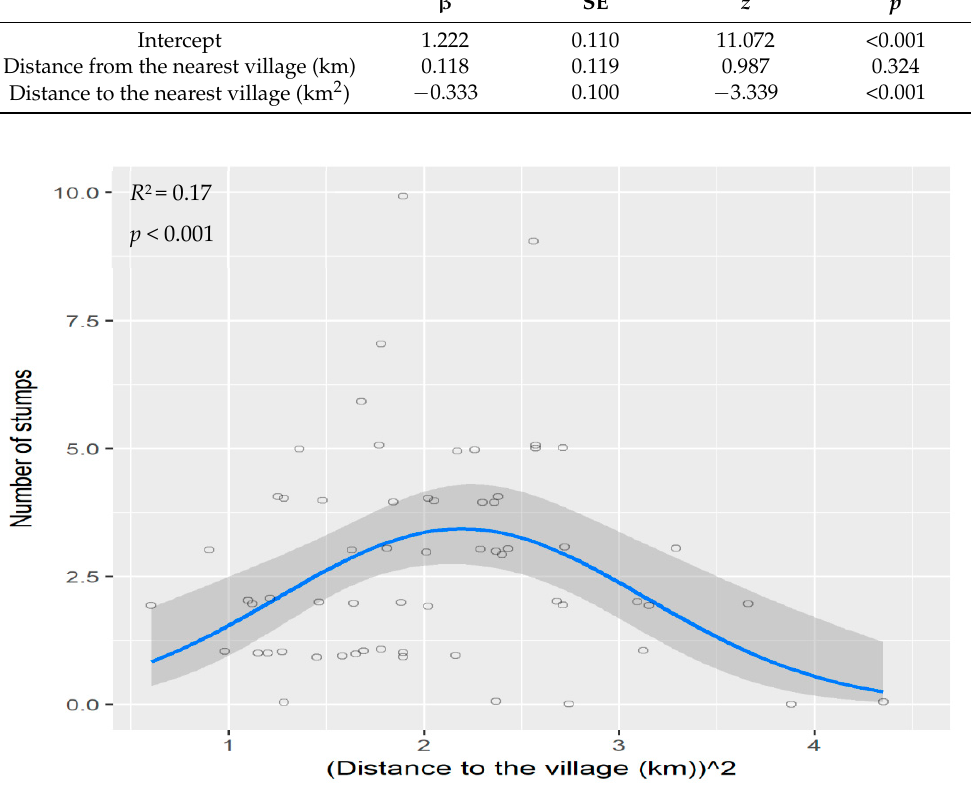
Figure 4. The relationship between the number of Olea europaea (Wall. ex G. Don) Cif. stumps and distance from the nearest village in Hugumburda dry Afromontane forest in northern Ethiopia. The solid lines indicate the fitted lines and the shaded polygons denote the 95% confidence intervals. The grey circles show observed values.